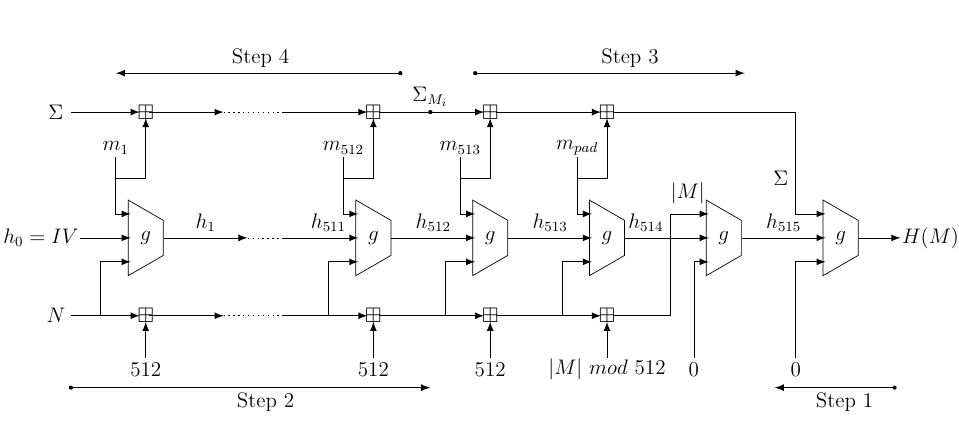
Figure 7: Framework of preimage attack on Streebog-512